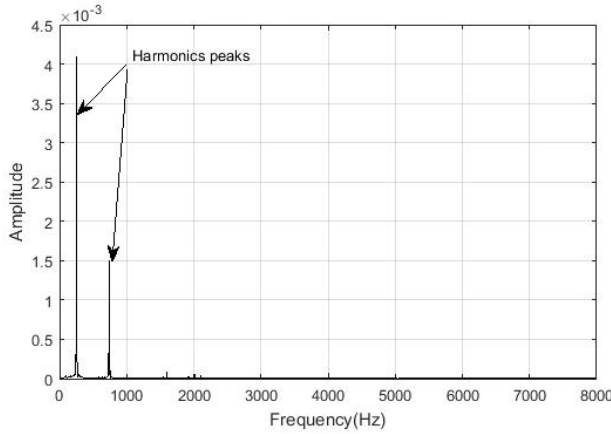
Figure 11. Healthy rotor spectrum before the noise reduction with the harmonic peaks.